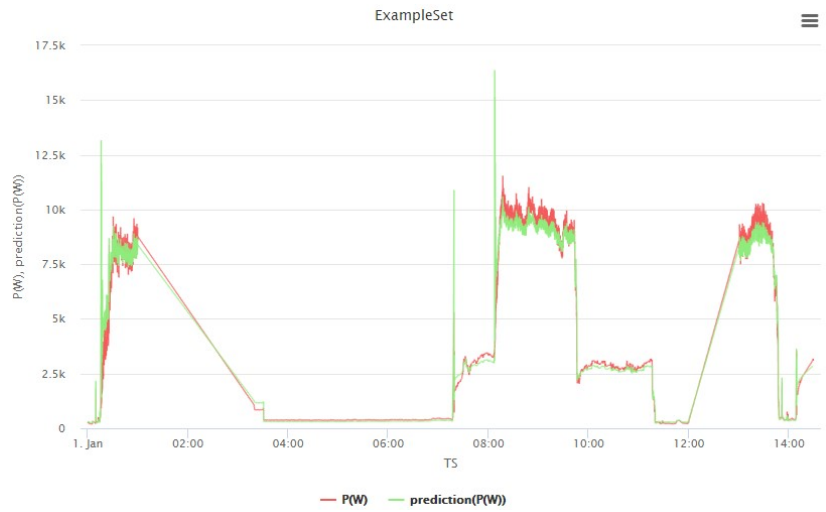
Figure 17. Visualization graph of SVM model.